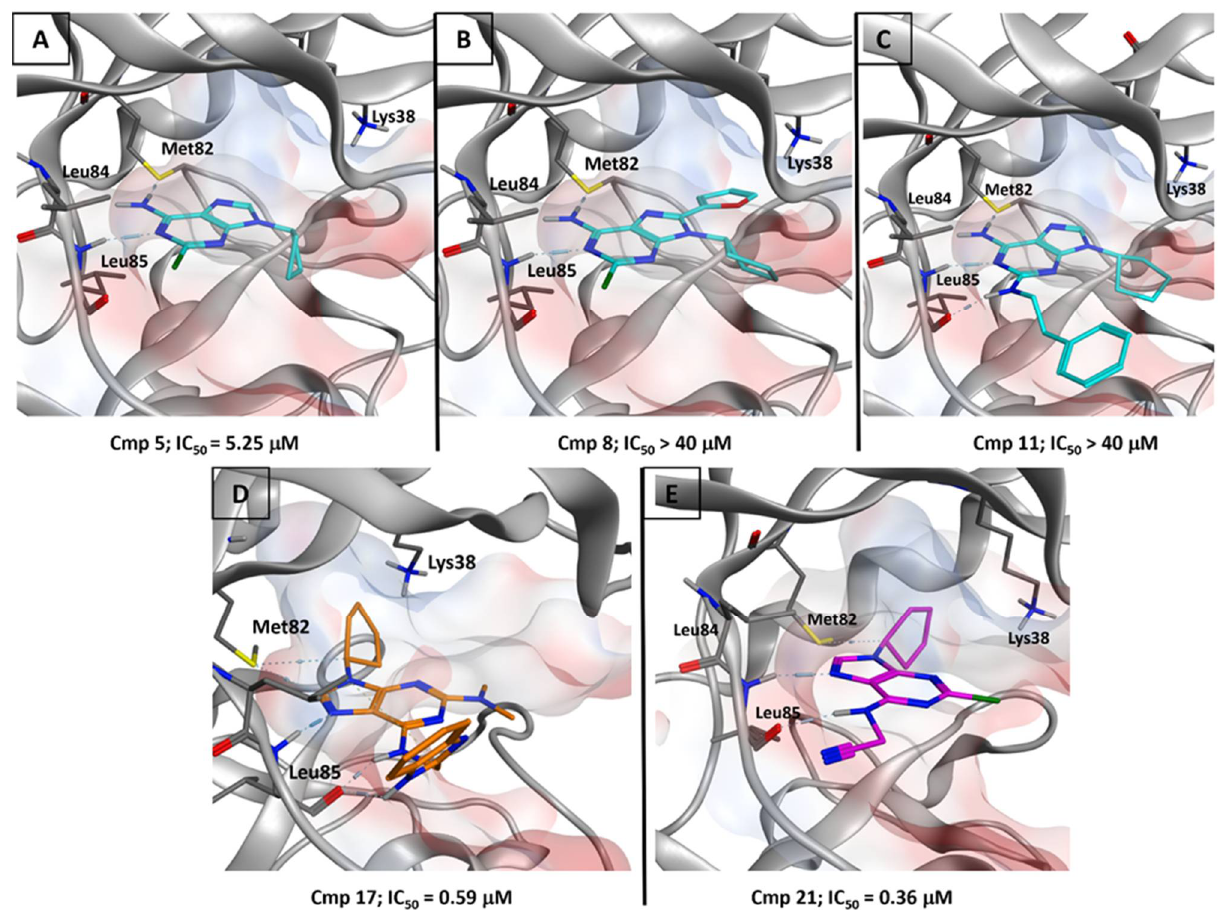
Figure 4. Depiction of the three-dimensional structure of the selected poses for some of the representative compounds tested for CK1δ inhibition. Panels ( A – E ) represent, respectively, compounds 5 , 8 , 11 , 17 , and 21 . For each image, the most important CK1 δ residues are labeled, and the electrostatic surface of the pocket is mapped and illustrated. The ligands are colored based on the “subseries” in which the molecules have been divided in Table 1. Compounds 5 , 8 , and 11 are colored in cyan, molecule 17 is colored orange, while ligand 21 is depicted in purple. The hydrogen bonds are indicated with dashed lines. All of the images were created and rendered with MOE.